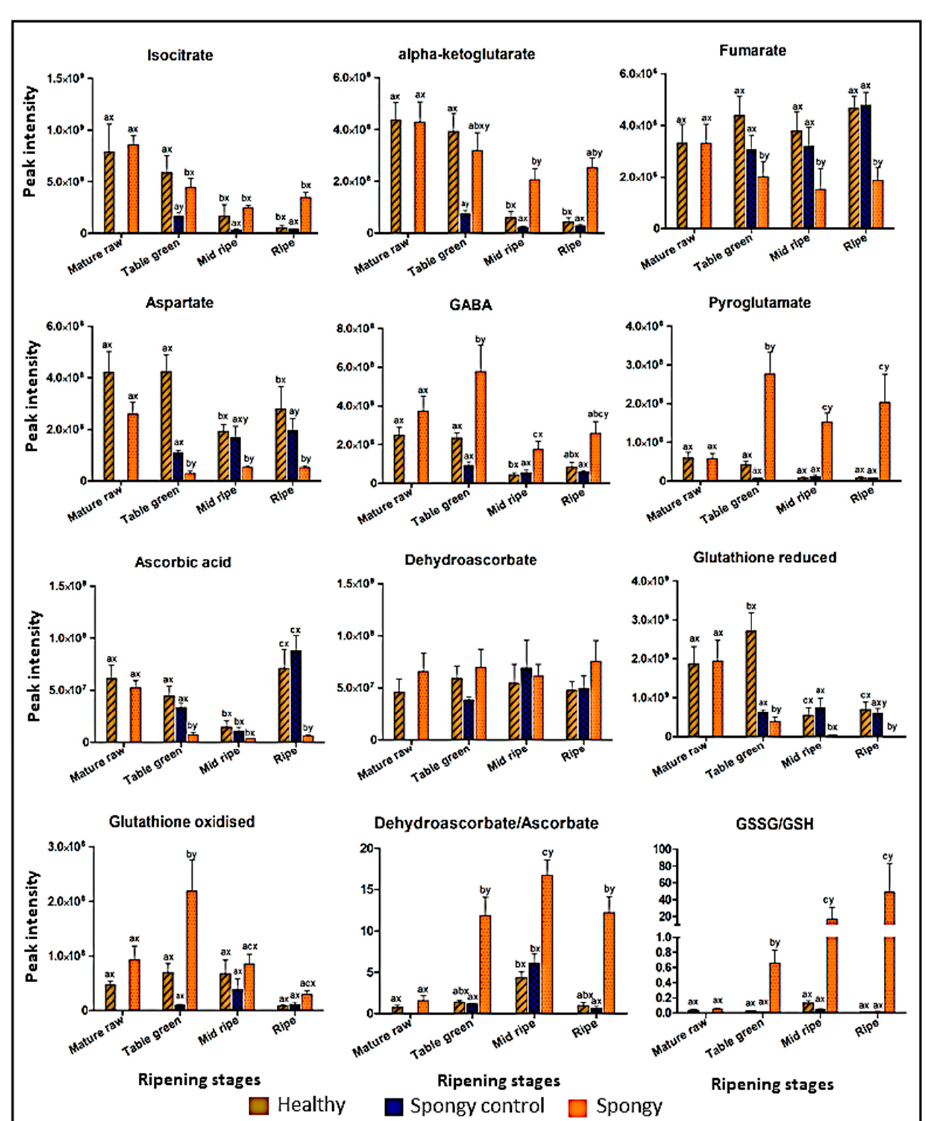
Figure 6. Metabolites involved in TCA Cycle, GABA shunt and Ascorbate glutathione cycle. Differential accumulation of metabolites in healthy, spongy control and spongy tissue within four stages of ripening (mature raw, table green, mid ripe and ripe) of Alphonso mango. Y-axis denotes the peak intensity values. Vertical bars represent standard error within six biological replicates. Difference between the stages of each tissue set was significant ( p ≤ 0.05) if lower case letters (a, b, c) are different. Difference between tissue sets at each ripening stage was significant ( p ≤ 0.05) if lower case letters (x, y, z) are different.